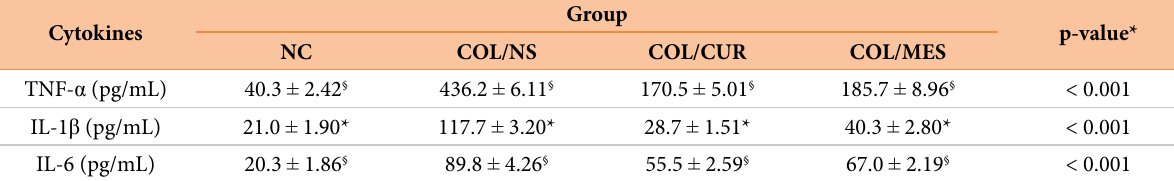
Table 4 - Effect of curcumin and mesalazine on TNF- α , IL-1 β and IL-6 levels in colon tissue #